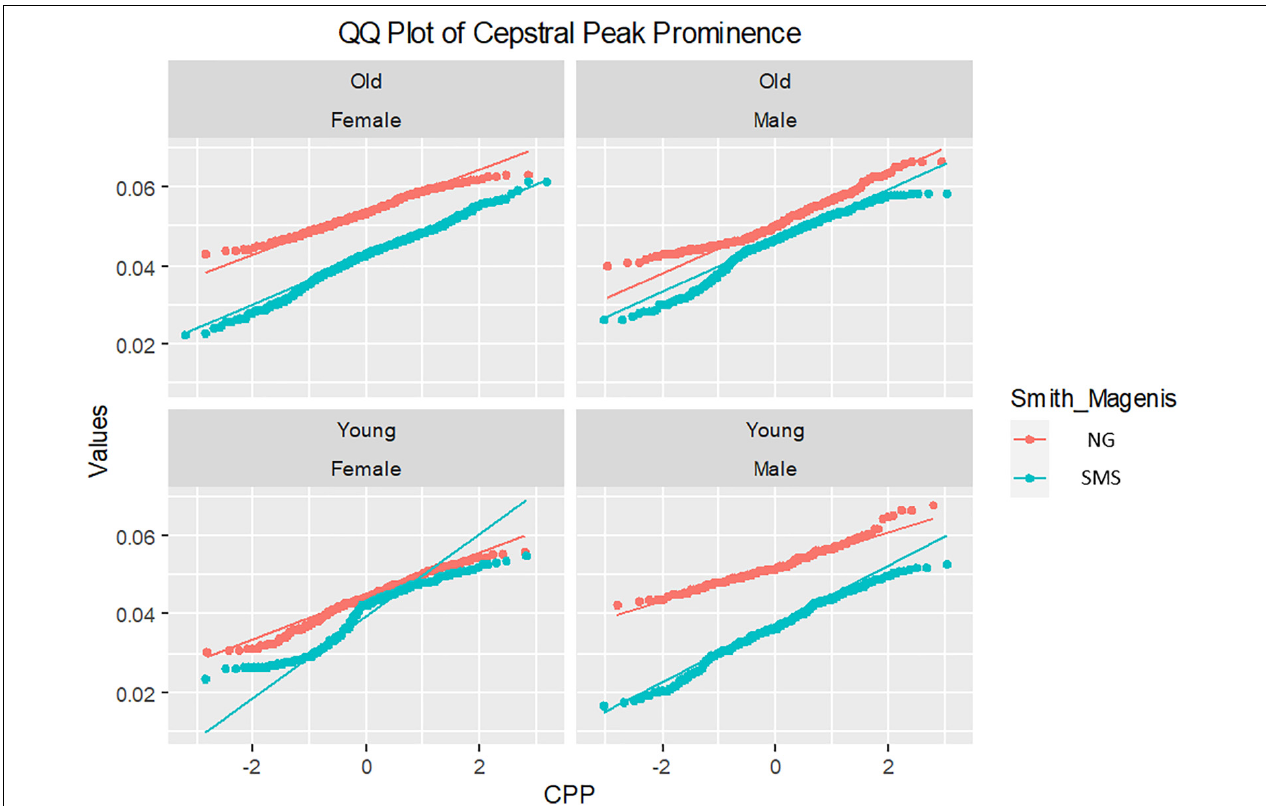
FIGURE 8 | Q–Q plot cepstral peak prominence (CPP) distributions of gender and ages groups. Notice that young and old legend refers to ages of groups (ranges 1 and 2,